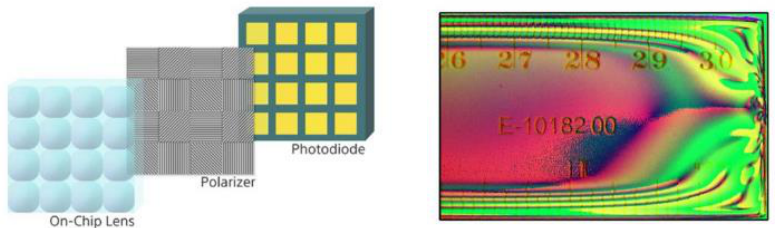
Figure 9. Structure of the split-focal plane polarization sensor IMX250 MZR. Right: Internal stress of a transparent ruler made visible by false color presentation of the polarization [42].